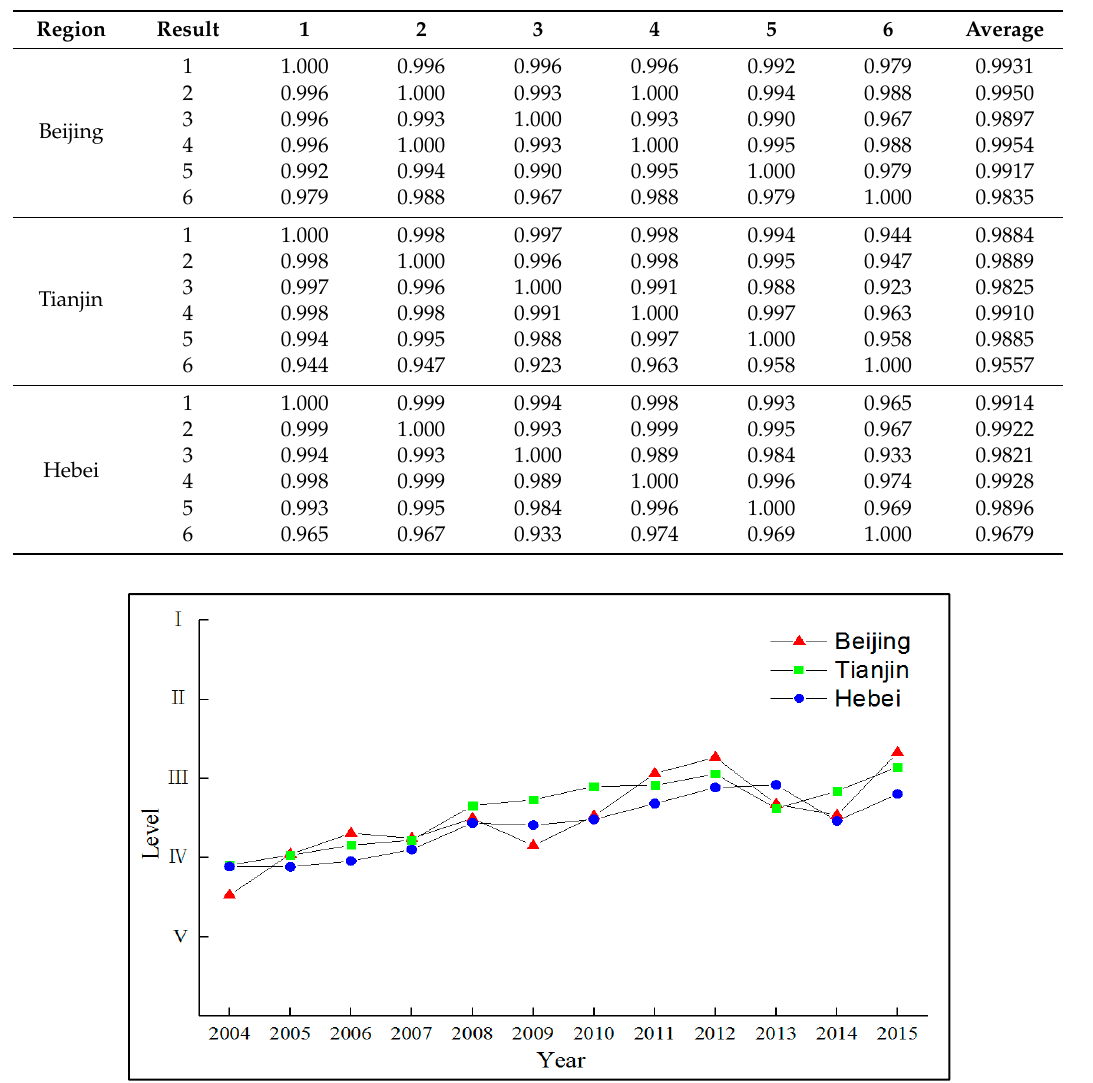
Figure 2. Evaluation of Sustainable Use of Water Resources in Beijing-Tianjin-Hebei Region.